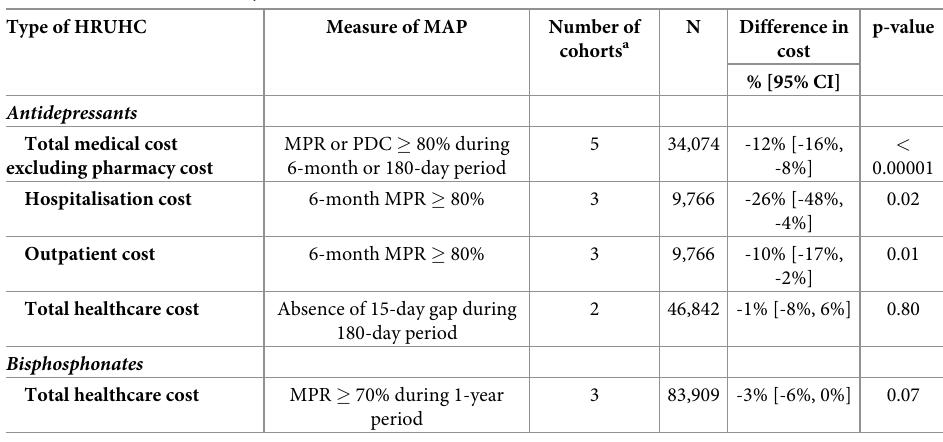
Table 11. Result of